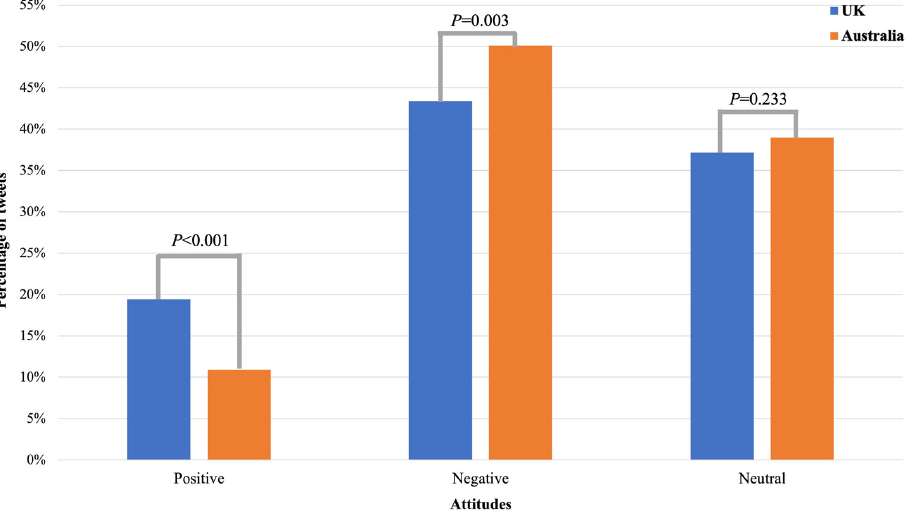
Figure 2. Attitudes towards the e-cigarette prescription policy on Twitter in the UK and Australia.